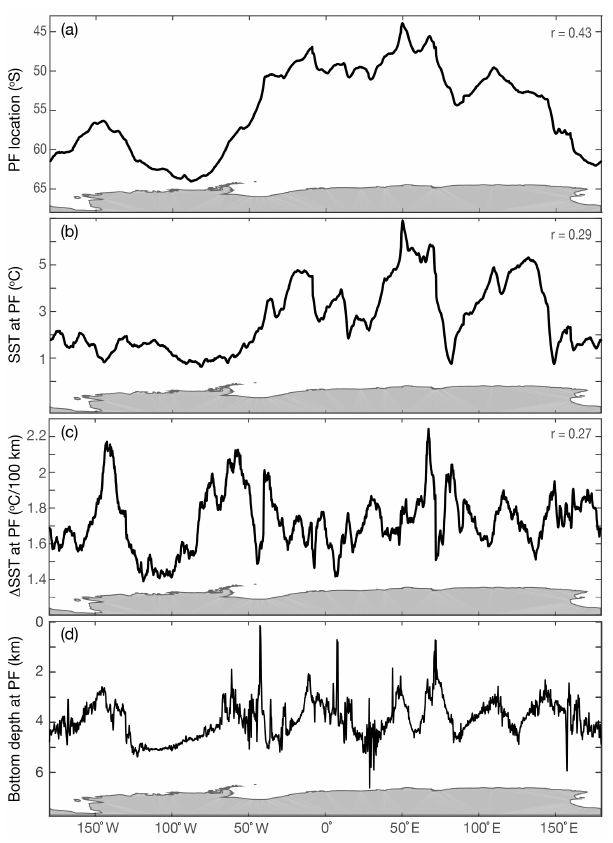
Figure 5. Climatological (a) PF location and (b) SST, (c) abso- lute SST gradient, and (d) bottom depth at the PF (June 2002– February 2014). Statistically significant ( > 95%) correlation coef- ficients with bottom depth are indicated in the top right corner of (a) – (c) .